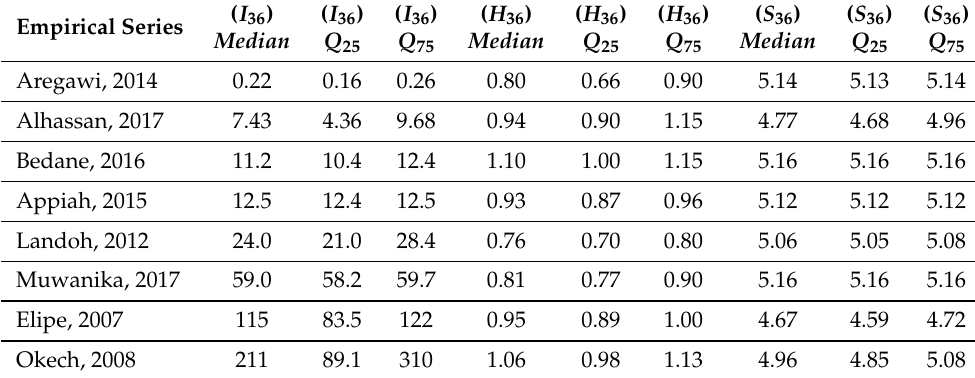
Table 2. Table with the empirical values of median, quartile 25 and 75 from the series of malaria incidence, entropy and the Hurst exponent, using moving windows of 36